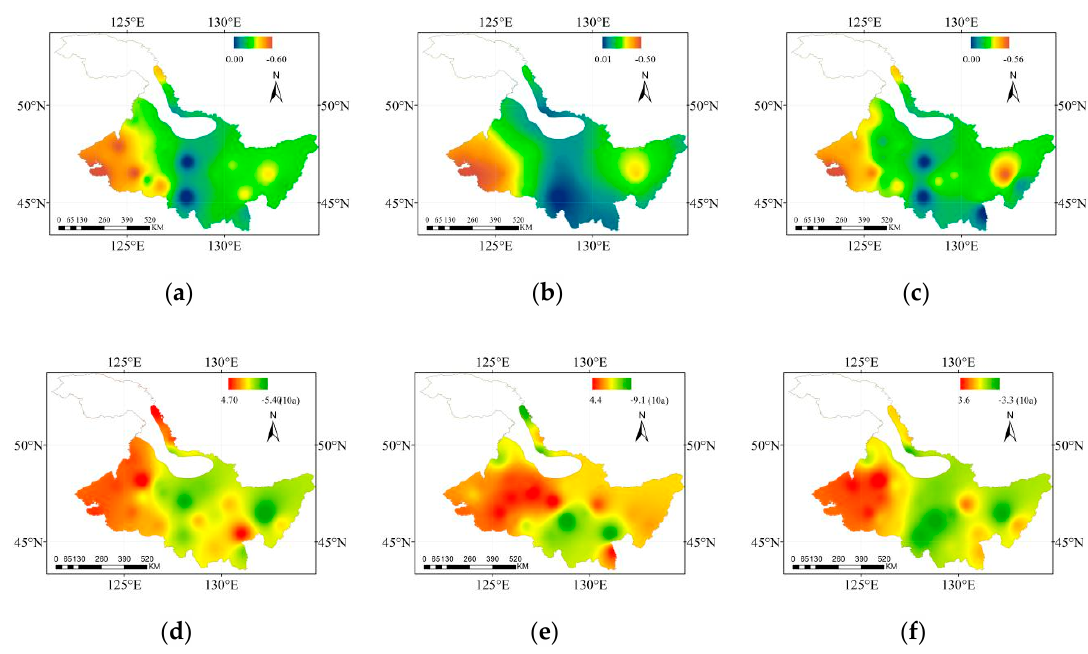
Figure 5. Average crop water surplus deficit index ( CWSDI ) during ( a ) 1960–1979, ( b ) 1980–1999, and ( c ) 2000–2015. Climate tendency rate of CWSDI during ( d ) 1960–1999, ( e ) 1980–2015, and ( f ) 1960–2015.